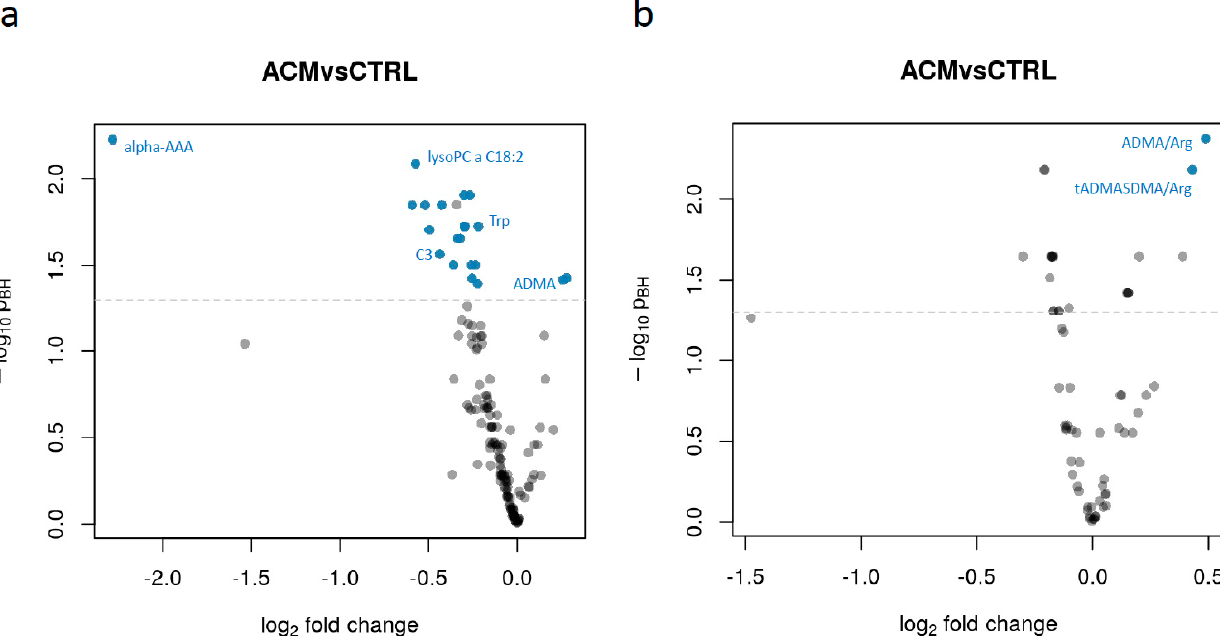
Figure 2. Volcano plots showing for each analyte the extent of differential abundance (log2 fold change) on the x-axis against its significance on the y-axis. ( a ) Results for individual metabolites, ( b ) results for metabolite sums and ratios. The blue dots indicate significant metabolites and metabolite sums/ratios. The name of some relevant metabolites is also fully reported. Alpha-AAA: alpha-aminoadipic acid; C3: carnitine C3; Trp: tryptophan; ADMA: asymmetric